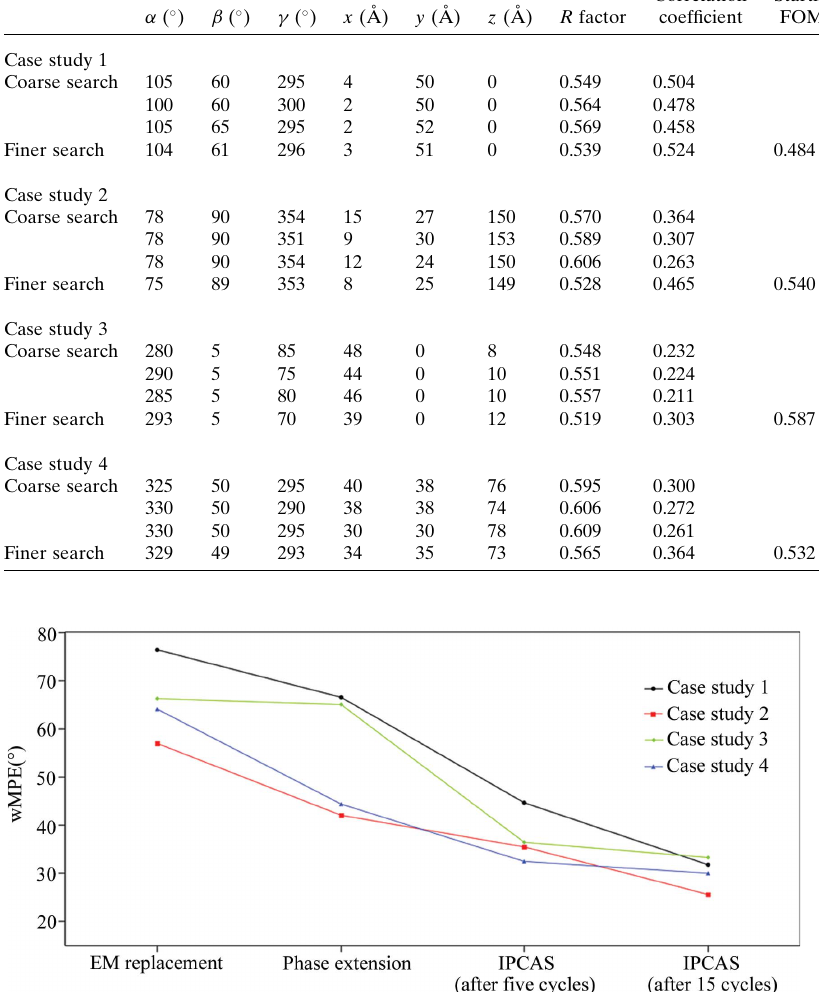
Table 2 Molecular-replacement solutions for four test cases. The results are given in ascending order of R factor for the top three solutions. The top solution was chosen to place the map in the unit cell and was output to .mtz files. (cid:2) ( (cid:3) ) (cid:3) ( (cid:3) )